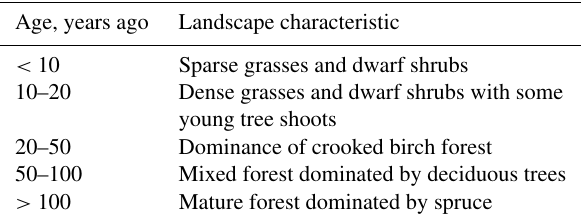
Table 1. Vegetation characteristics for indicating the age of debris or slush flow deposit, established for the forest belt in the Khibiny Mountains (after Bozhinsky and Myagkov,